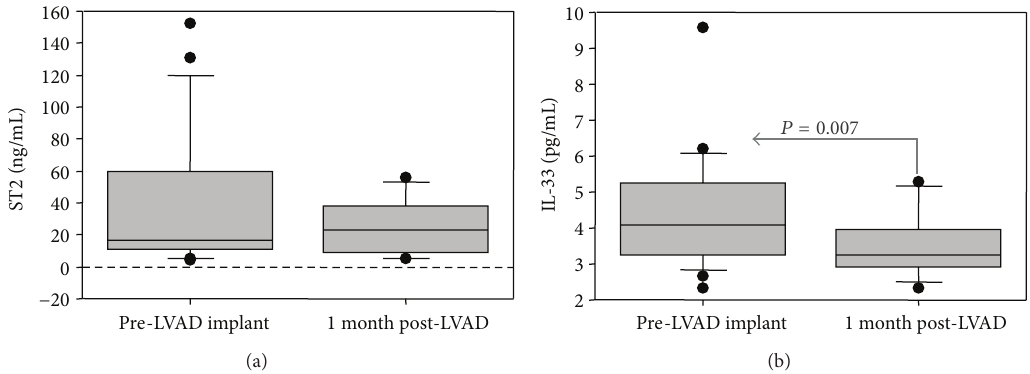
Figure 2: Effect of 1 month LVAD support on sST2 (a) and IL-33 (b) circulating